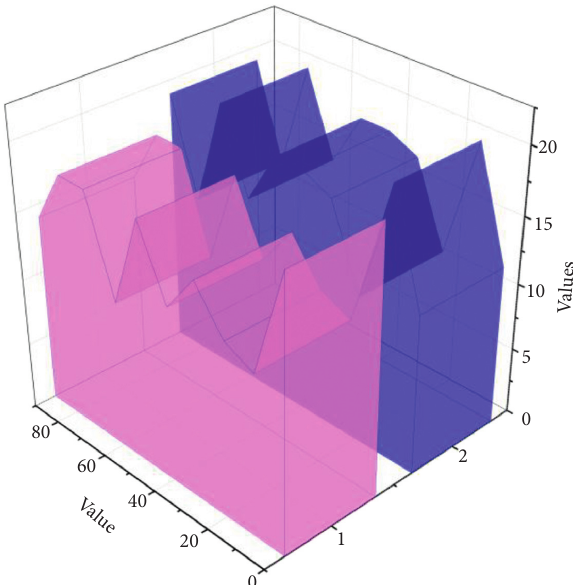
Figure 9: Random handle simulation results.